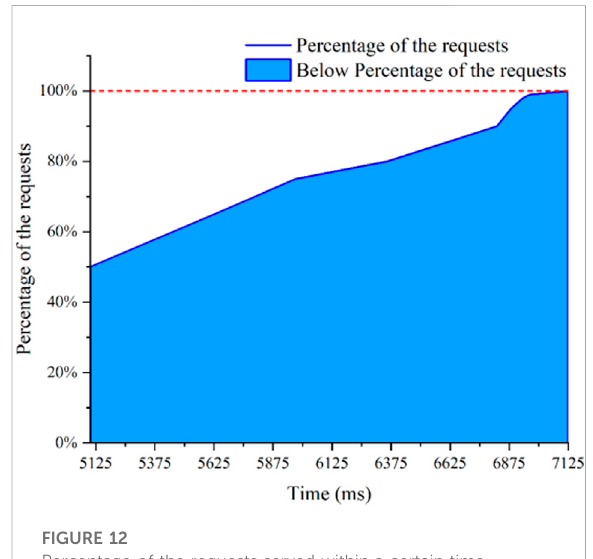
Percentage of the requests served within a certain time.